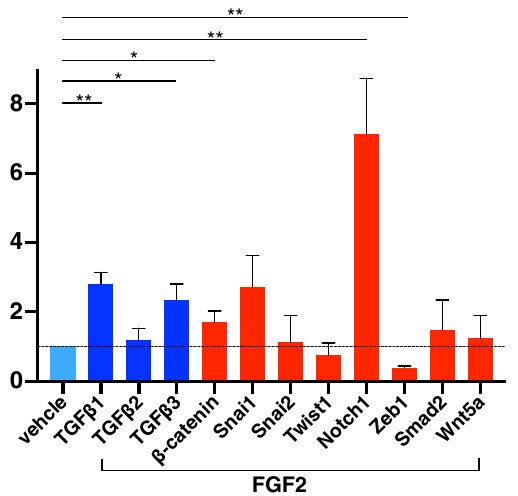
Figure 4. Representative EMT-associated upregulated genes in PCR array analysis. Individual genes of the FGF2 group were normalized by the same gene of vehicle group respectively. TGFβ1 (2.79 fold: p < 0.01), TGFβ2 (1.18 fold), TGFβ3 (2.34 fold: p < 0.05), β-catenin (1.70 fold: p < 0.05) and Notch1 (7.14 fold: p < 0.01) were up-regulated and Zeb1 (0.39 fold: p < 0.01) was down-regulated significantly in comparison with vehicle- treated samples. Bar graph is presented with the mean values ± standard error. * p < 0.05, ** p < 0.01, Mann– Whitney U